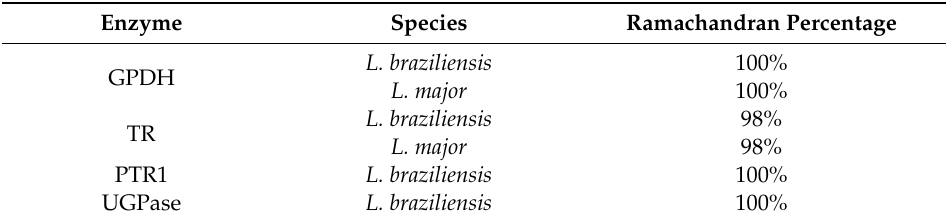
Table 4. Percentage of amino acids present in the permitted and favored regions of the Ramachandran chart for each